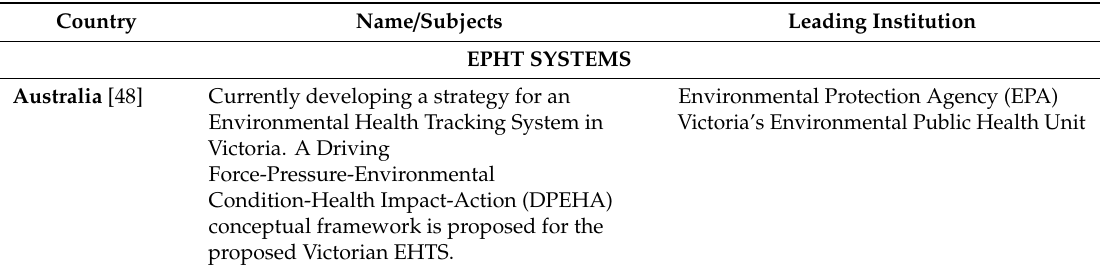
Table 2. Tracking activities around the globe that are collaborating in an international EPHT network